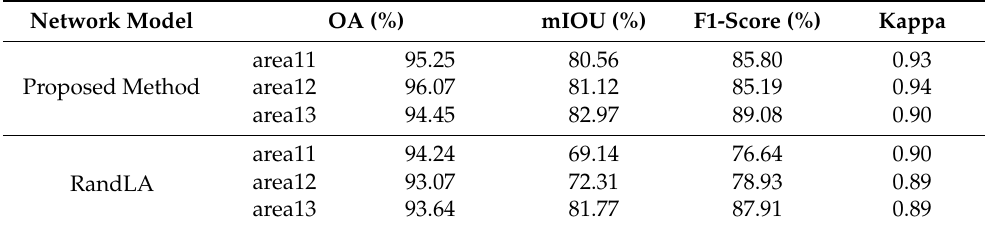
Table 3. The evaluation metrics for the original RandLA and the proposed method in this paper. Network